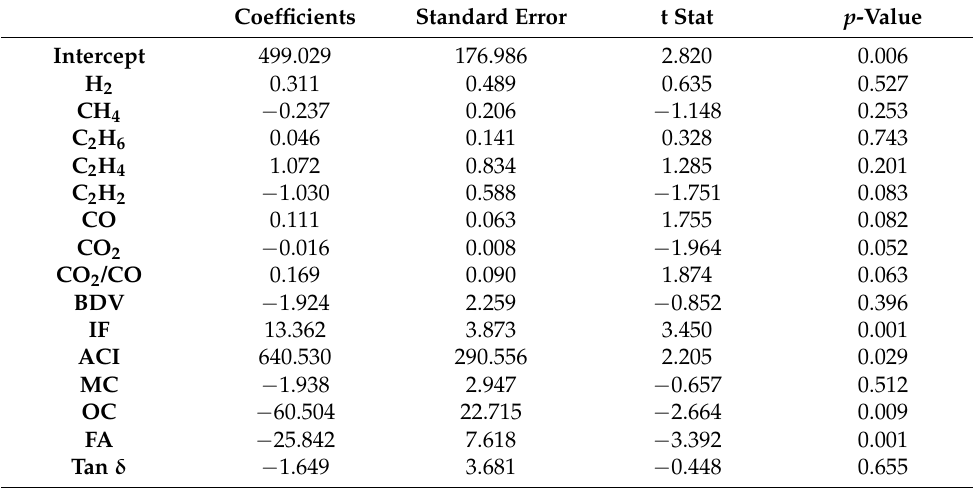
Table 3. Statistical parameters of the multiple linear regression.